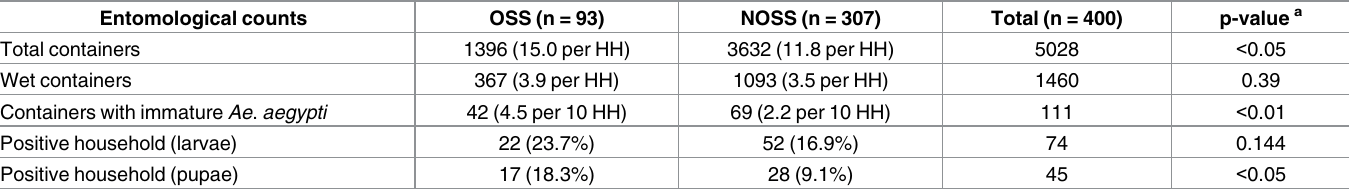
Table 3. Entomological counts by outdoor spatial spraying perception.